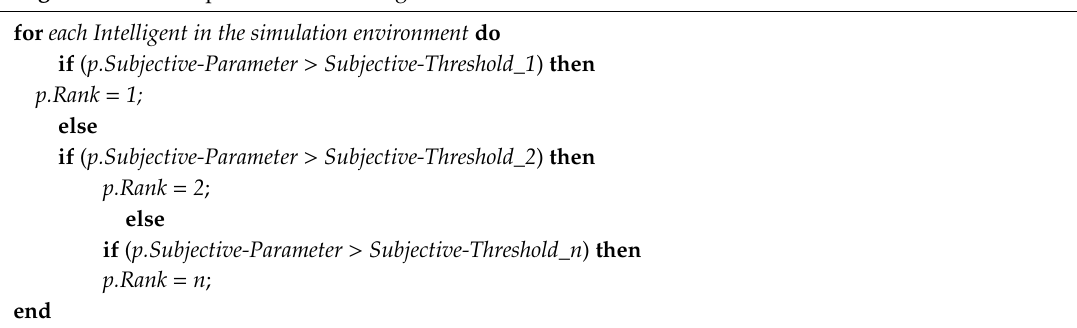
Algorithm 3: Multiple Levels of